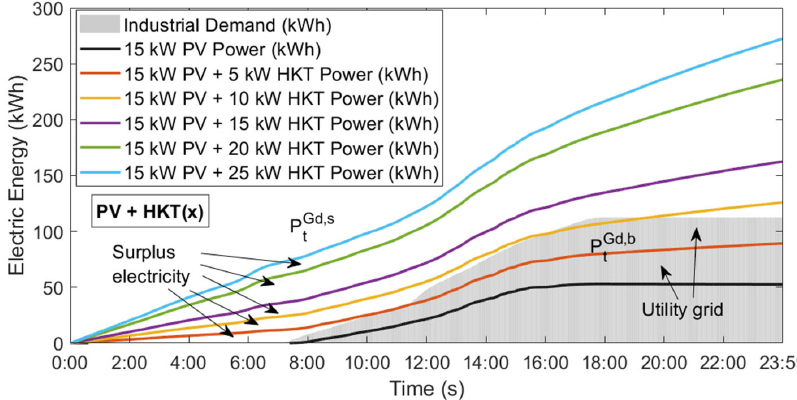
Figure 16. Sensitivity analysis with respect to the HKT capacity, PV = 15 kW, WT = 0 kW, and LI = 50 kWh.